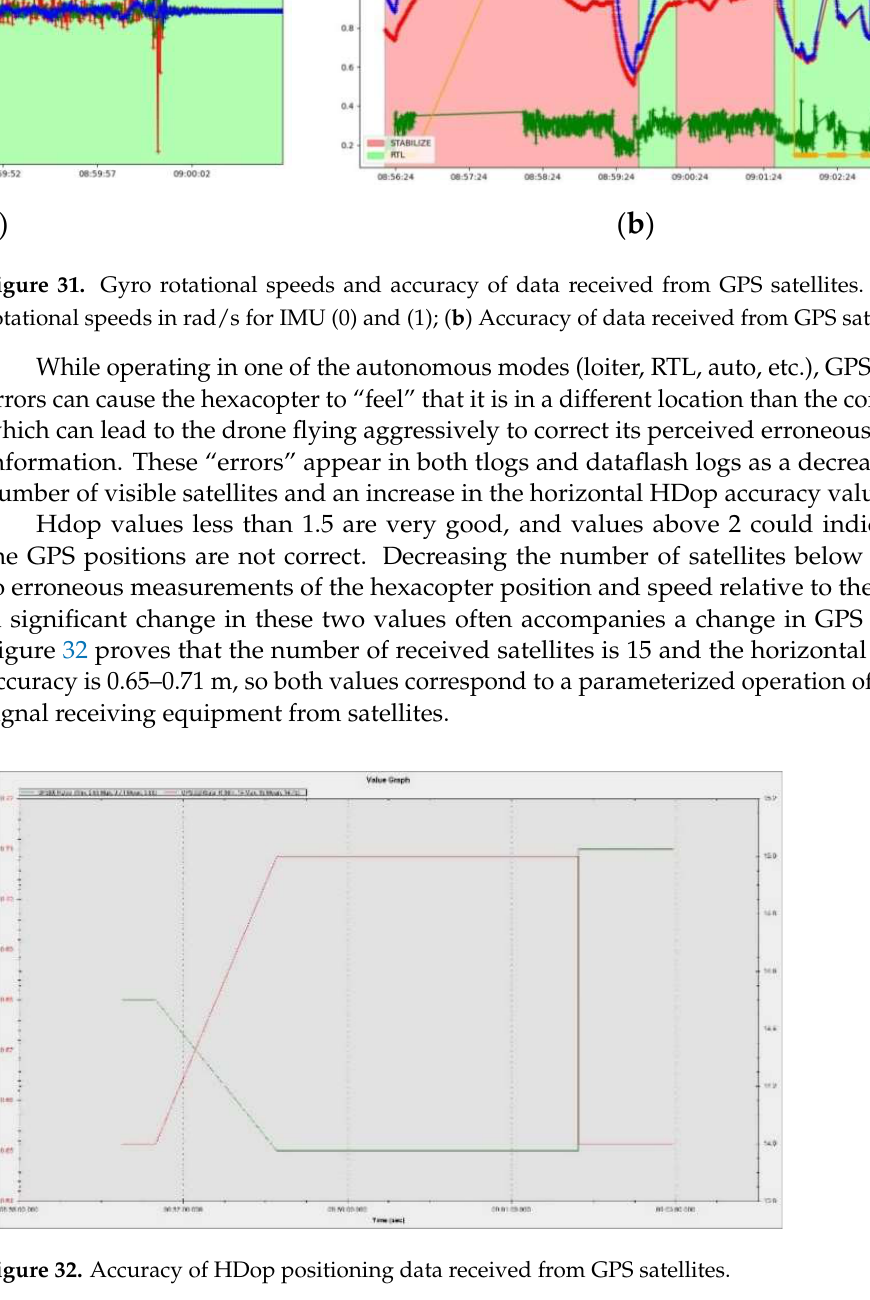
Figure 31. Gyro rotational speeds and accuracy of data received from GPS satellites. ( a ) Gyro